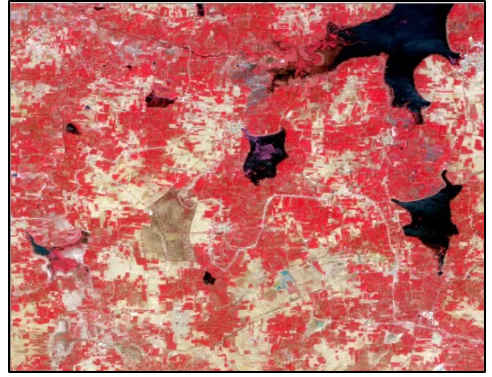
Figure 3: LISS IV image of Tiptur District